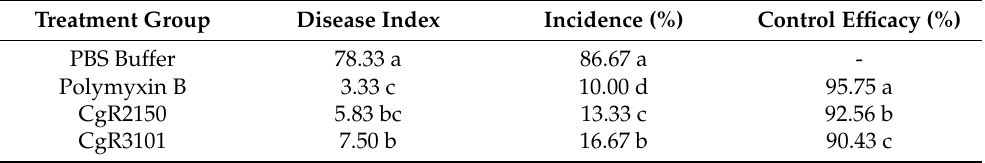
Table 1. Control effects of peptides CgR2150 and CgR3101 on C. michiganensis .